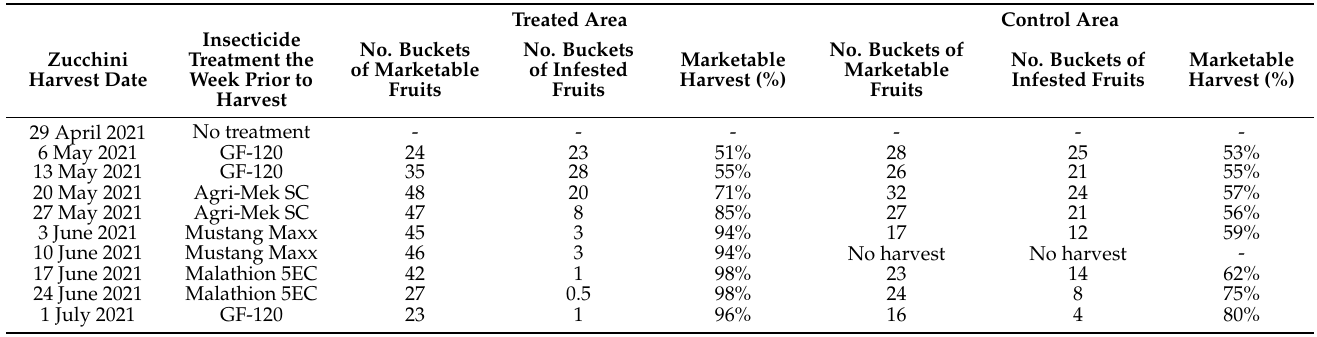
Table 5. Yield of marketable zucchini fruits (numbers of 4-gallon buckets filled) and Zeugodacus cucurbitae -infested fruits during the insecticide rotation trial at the Maui commercial farm. The data was collected by the farm